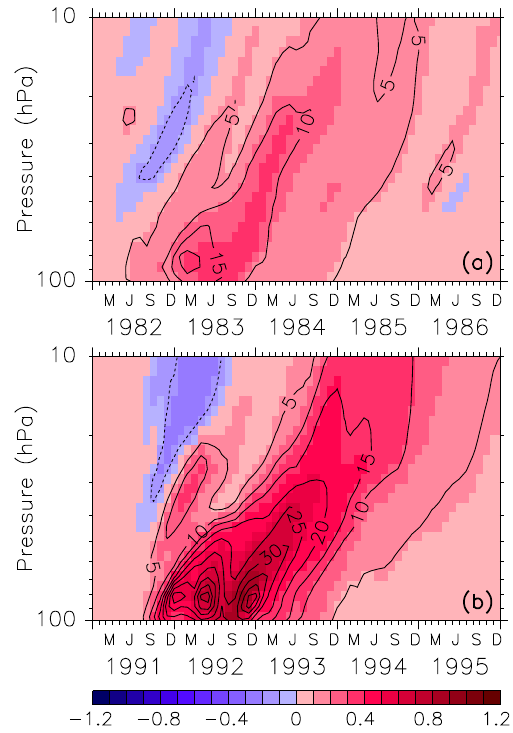
Figure 6. SWV (ppmv, colours) as absolute differences (VOL- NOVOL) in the tropics (5 ◦ S–5 ◦ N), zonally averaged for (a) the 1982 El Chichón and (b) the 1991 Mount Pinatubo eruption. Con- tours indicate relative changes of water vapour (interval 5%) com- pared to the background value of NOVOL. The small signal seen in 1986 is associated with the November 1985 eruption of Nevado del Ruiz (Colombia).